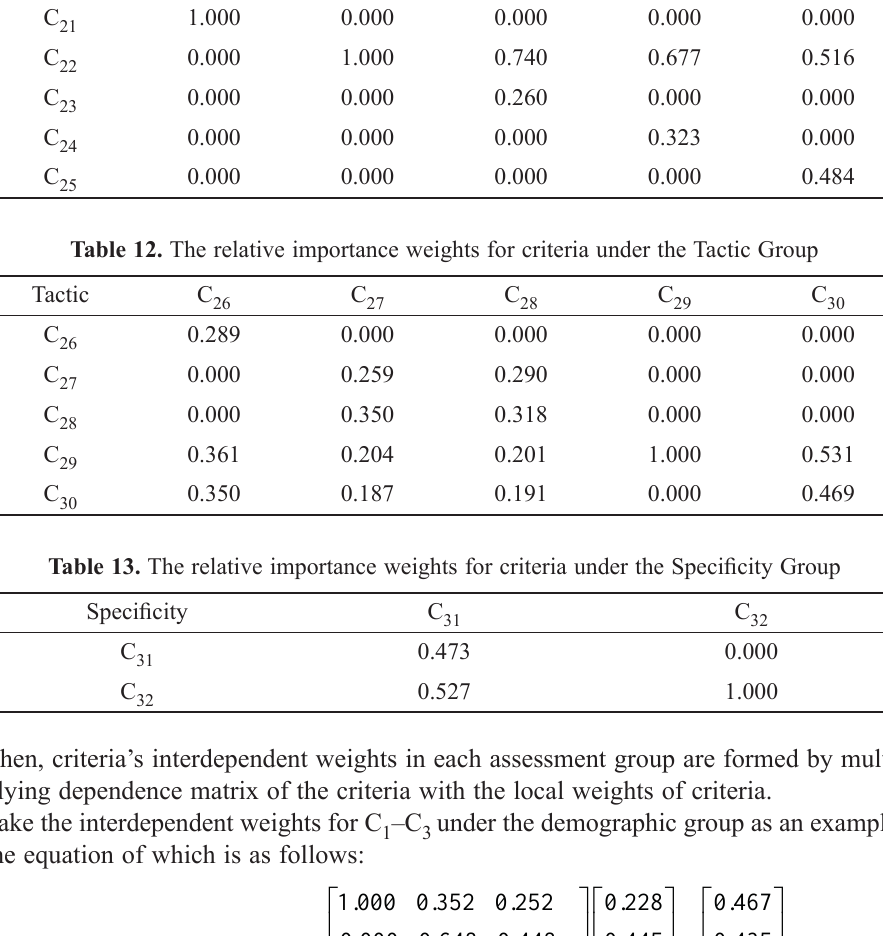
Table 11. The relative importance weights for criteria under the Relationship Group Relationship